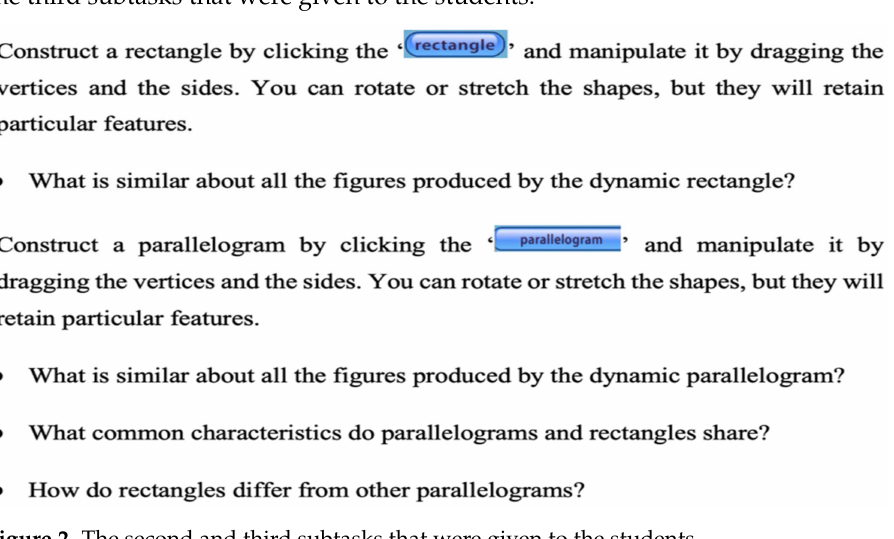
Figure 2. The second and third subtasks that were given to the